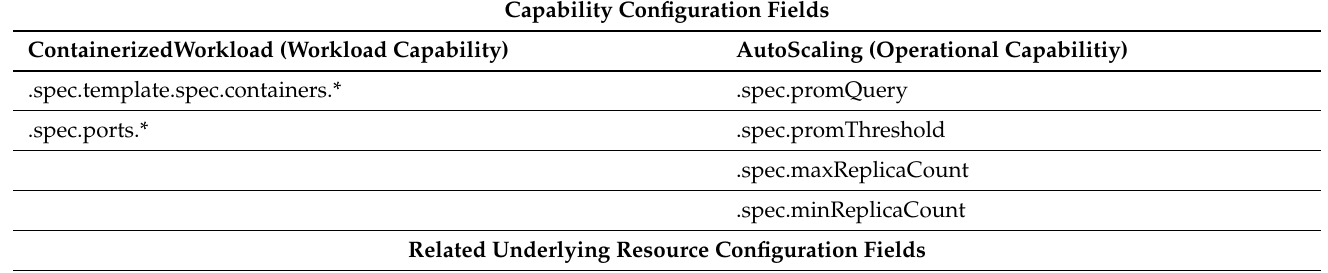
Table 2. Comparison of orchestration configuration